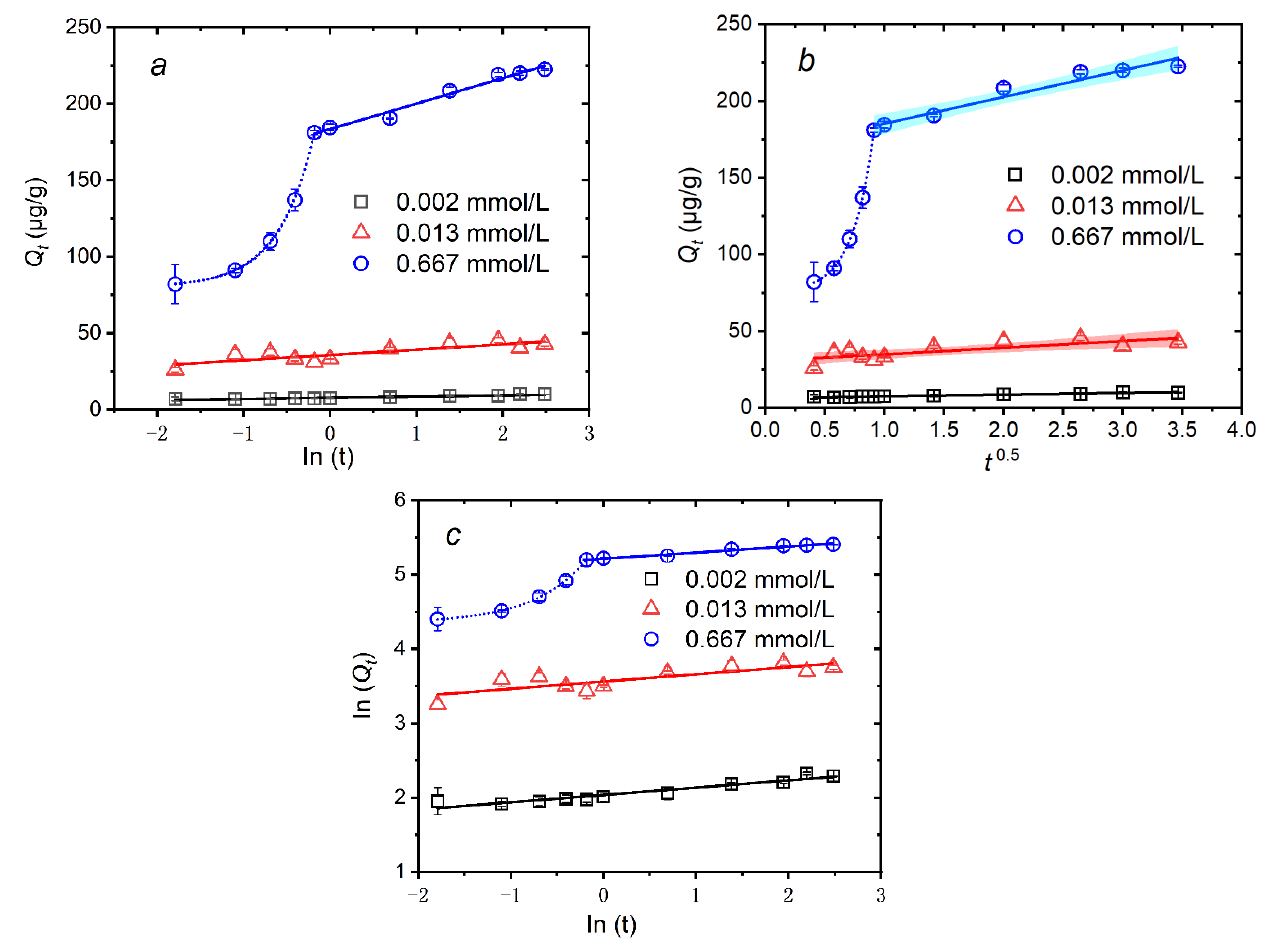
Figure 3. Fitting curves of MTAs V adsorption on the natural sediment using elovich ( a ), intraparticle diffusion ( b ), and fractional power ( c ) models, respectively. The shadow represents the confidence band under the 95% confidence level for fitting curves.